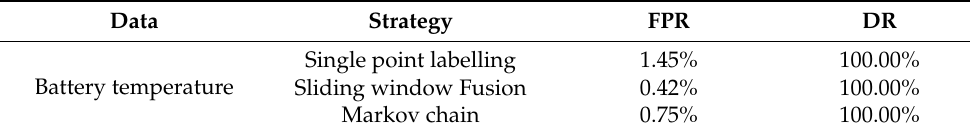
Table 5. The detection results based on the GPR model under different labelling